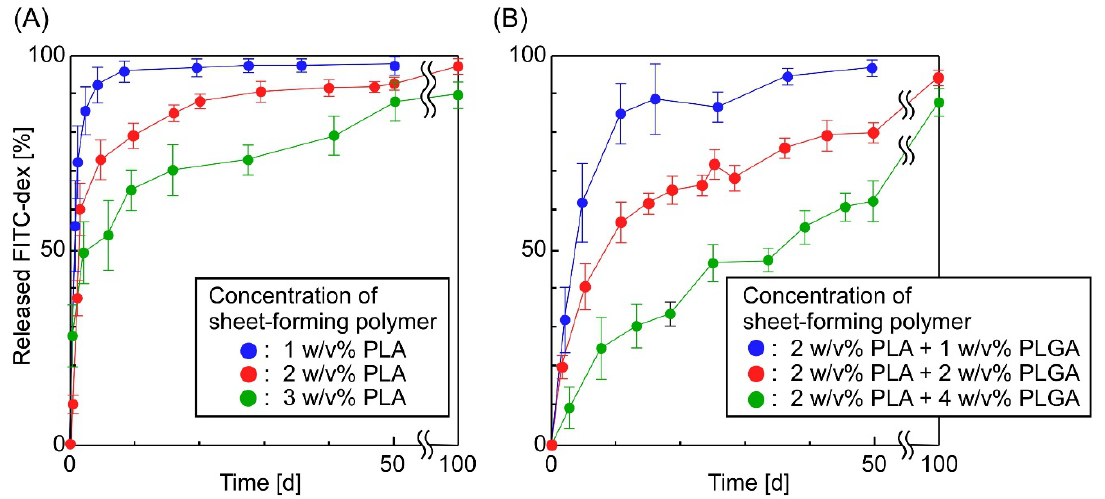
Figure 5. The effect of the concentration of sheet-forming polymers on the release properties of the sheets (the sheet-forming polymers were ( A ) PLA and ( B ) PLA (2 w/v%) + PLGA; number of layers: 11).